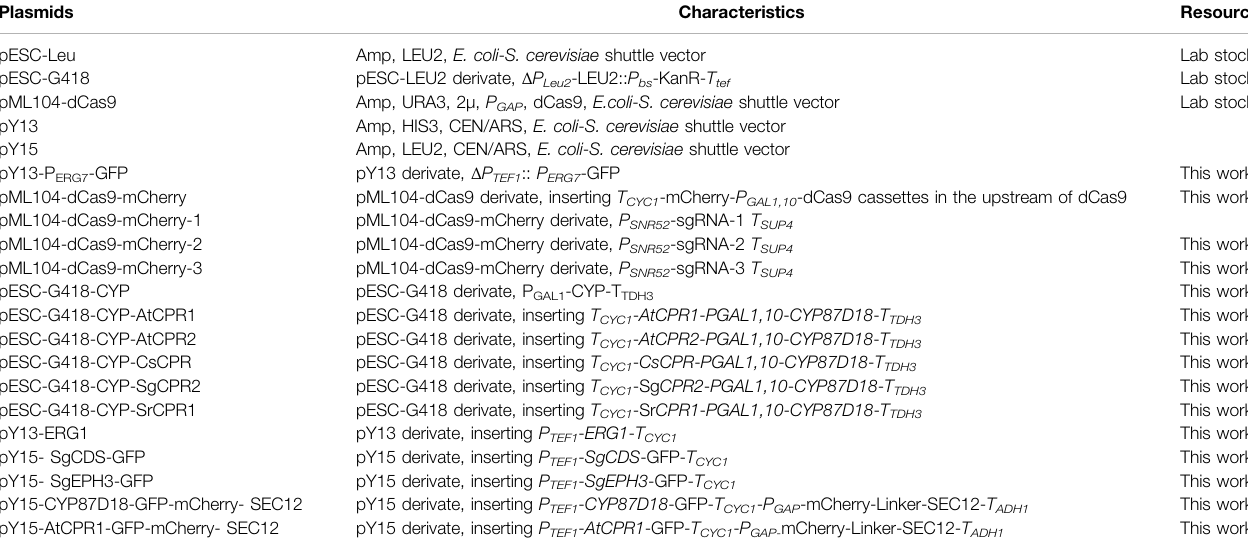
TABLE 2 | Plasmids used in the